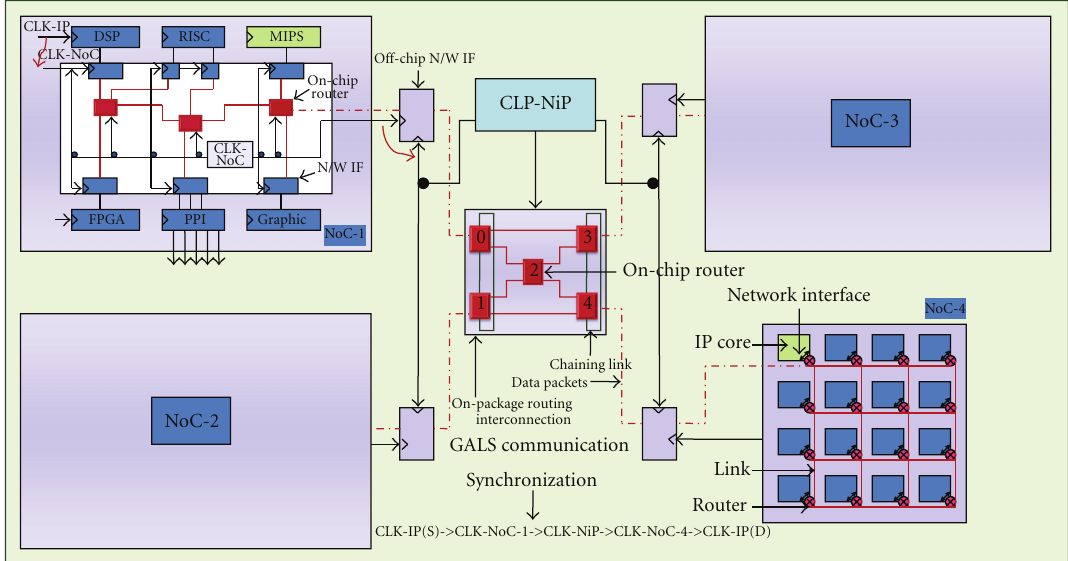
Figure 1: Parallel communication among various NoCs using PNN.